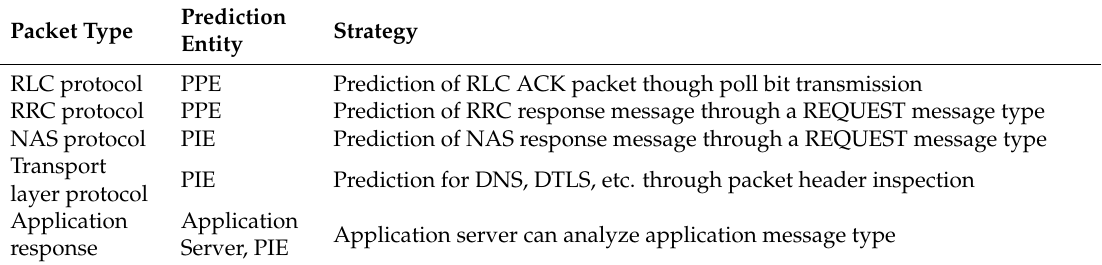
Table 1. Predictable packet types.